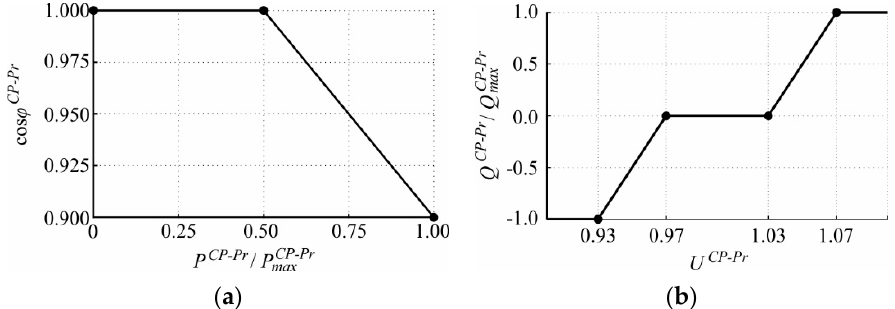
Figure 7. Different control characteristics for PV inverters: ( a ) cos φ ( P ); ( b ) Q ( U